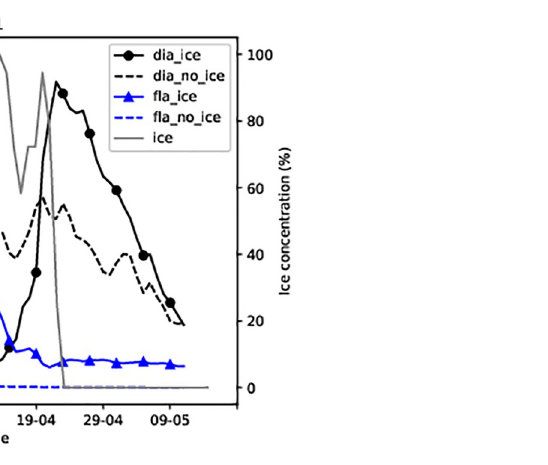
Fig 5. Modelled diatom and dinoflagellate concentrations at station G1.